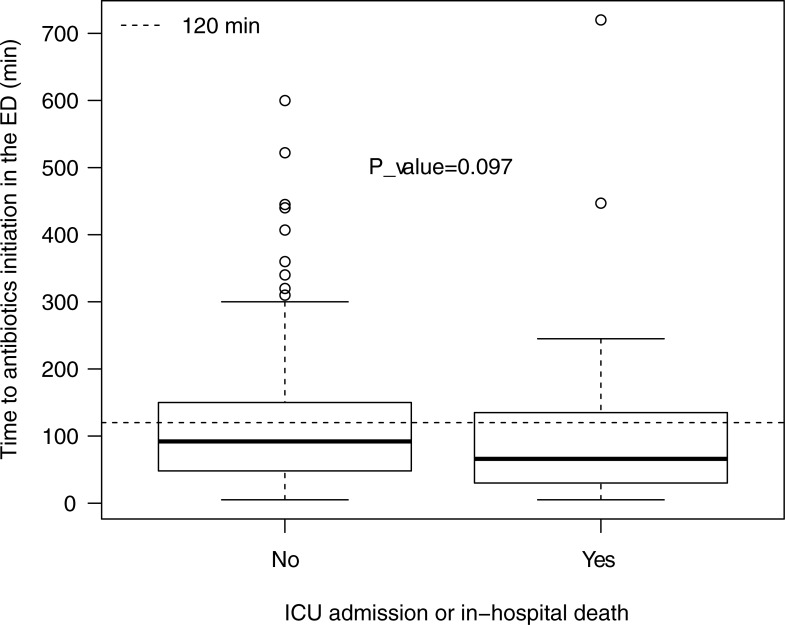
Boxplot.Time to antibiotics initiation in the ED depending on the outcome (ICU or death during hospital stay). Median and IQR were 92 [48–150] min for those who did not meet the outcome and 66 [30–135] min for those who did with no statistical difference according to the Wilcoxon Mann Whitney test (p = 0.097).